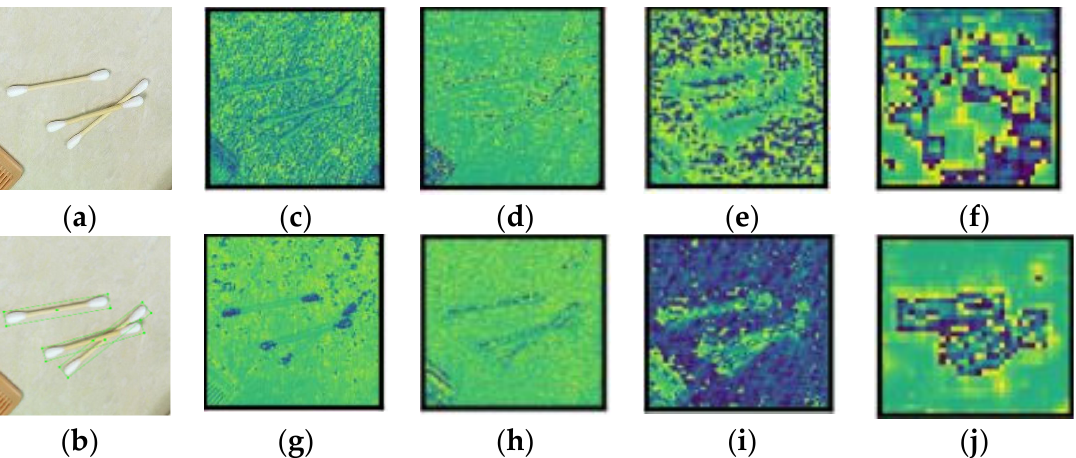
Figure 11. Intermediate characteristic diagrams of YOLOv5 and YOLOv5m-DSM. ( a ) Input image. ( b ) Label image. ( c – f ) Down sampling feature maps of YOLOv5. ( g – j ) Down sampling feature maps of YOLOv5m-DSM.